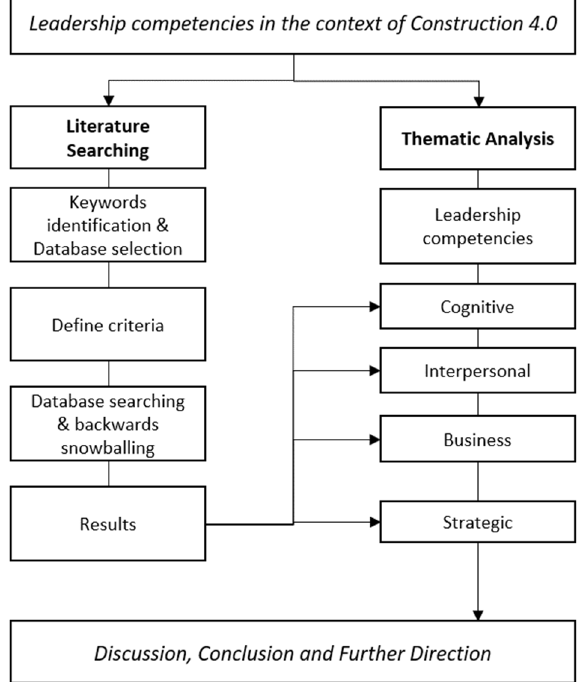
Figure 1. Methodological approach.